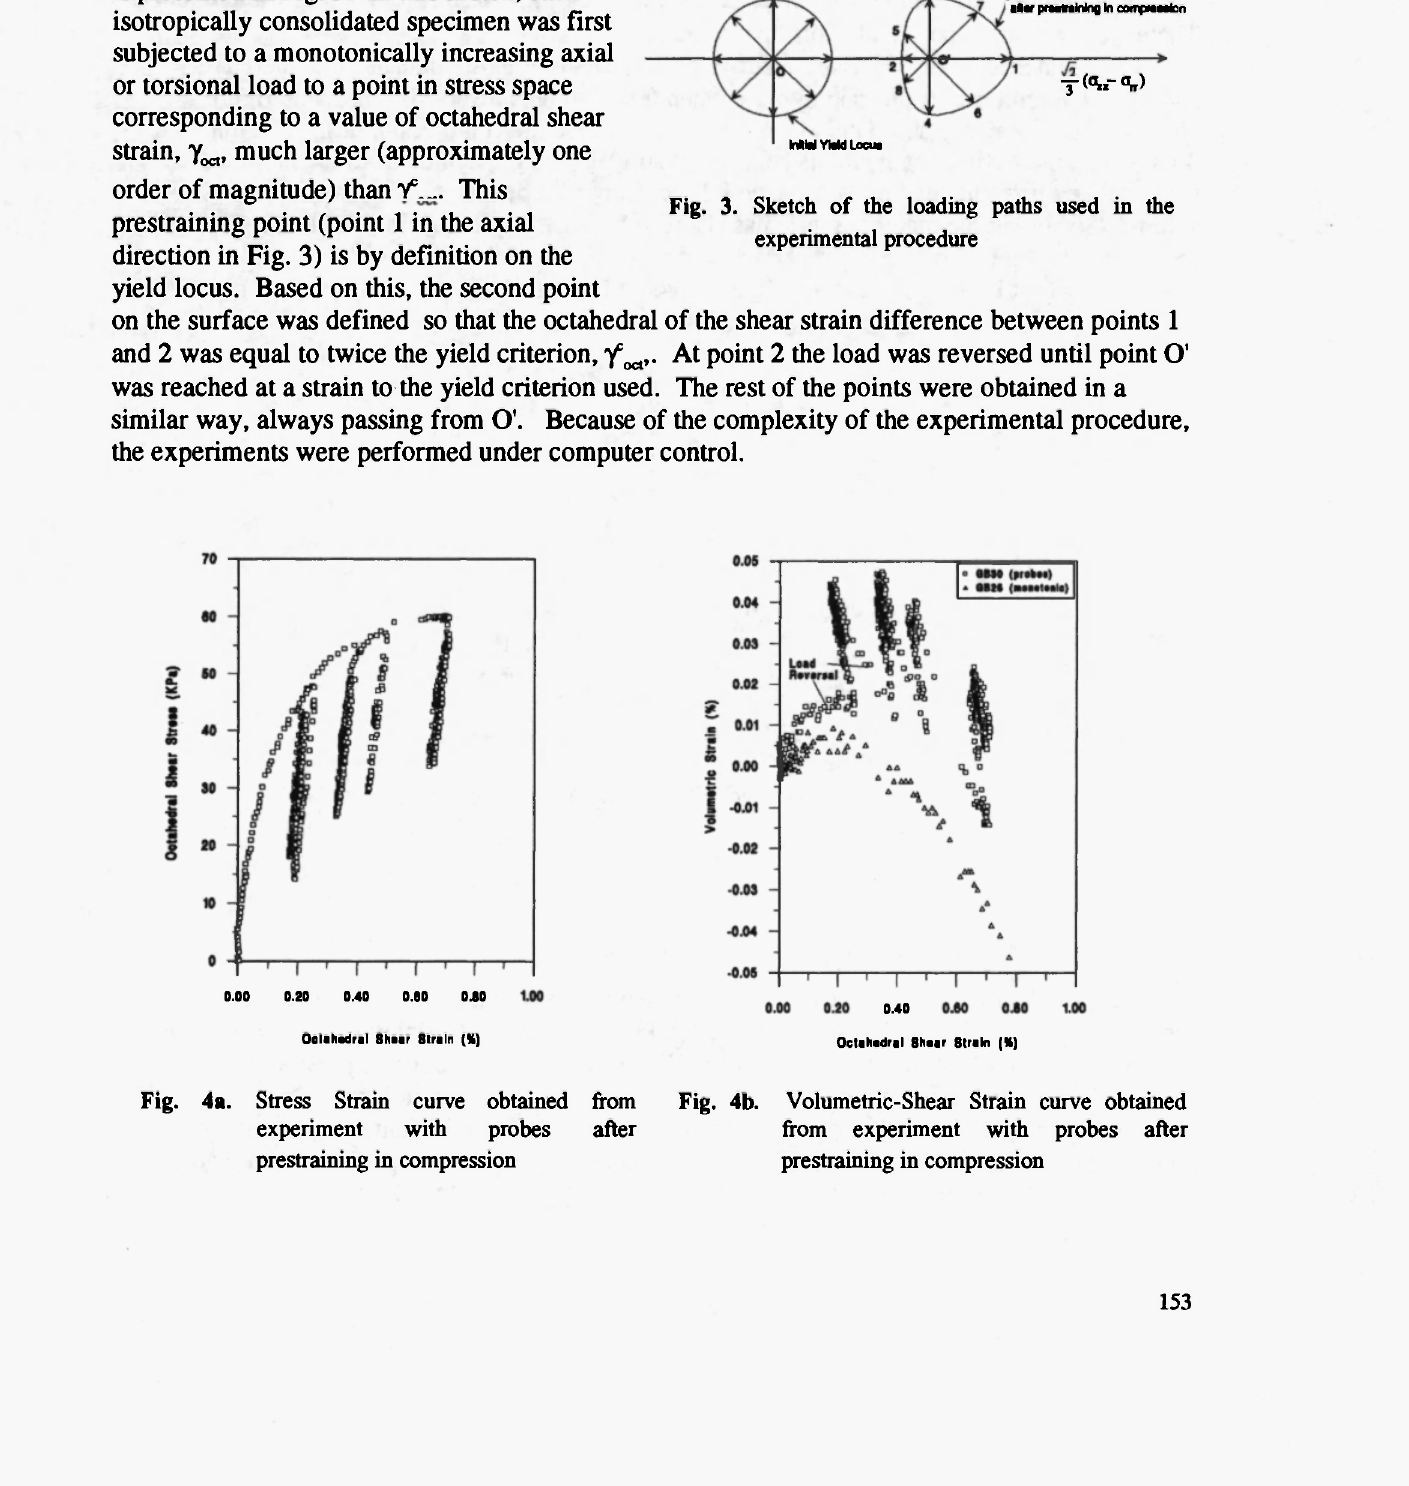
Fig. 3. Sketch of the loading paths used in the experimental procedure